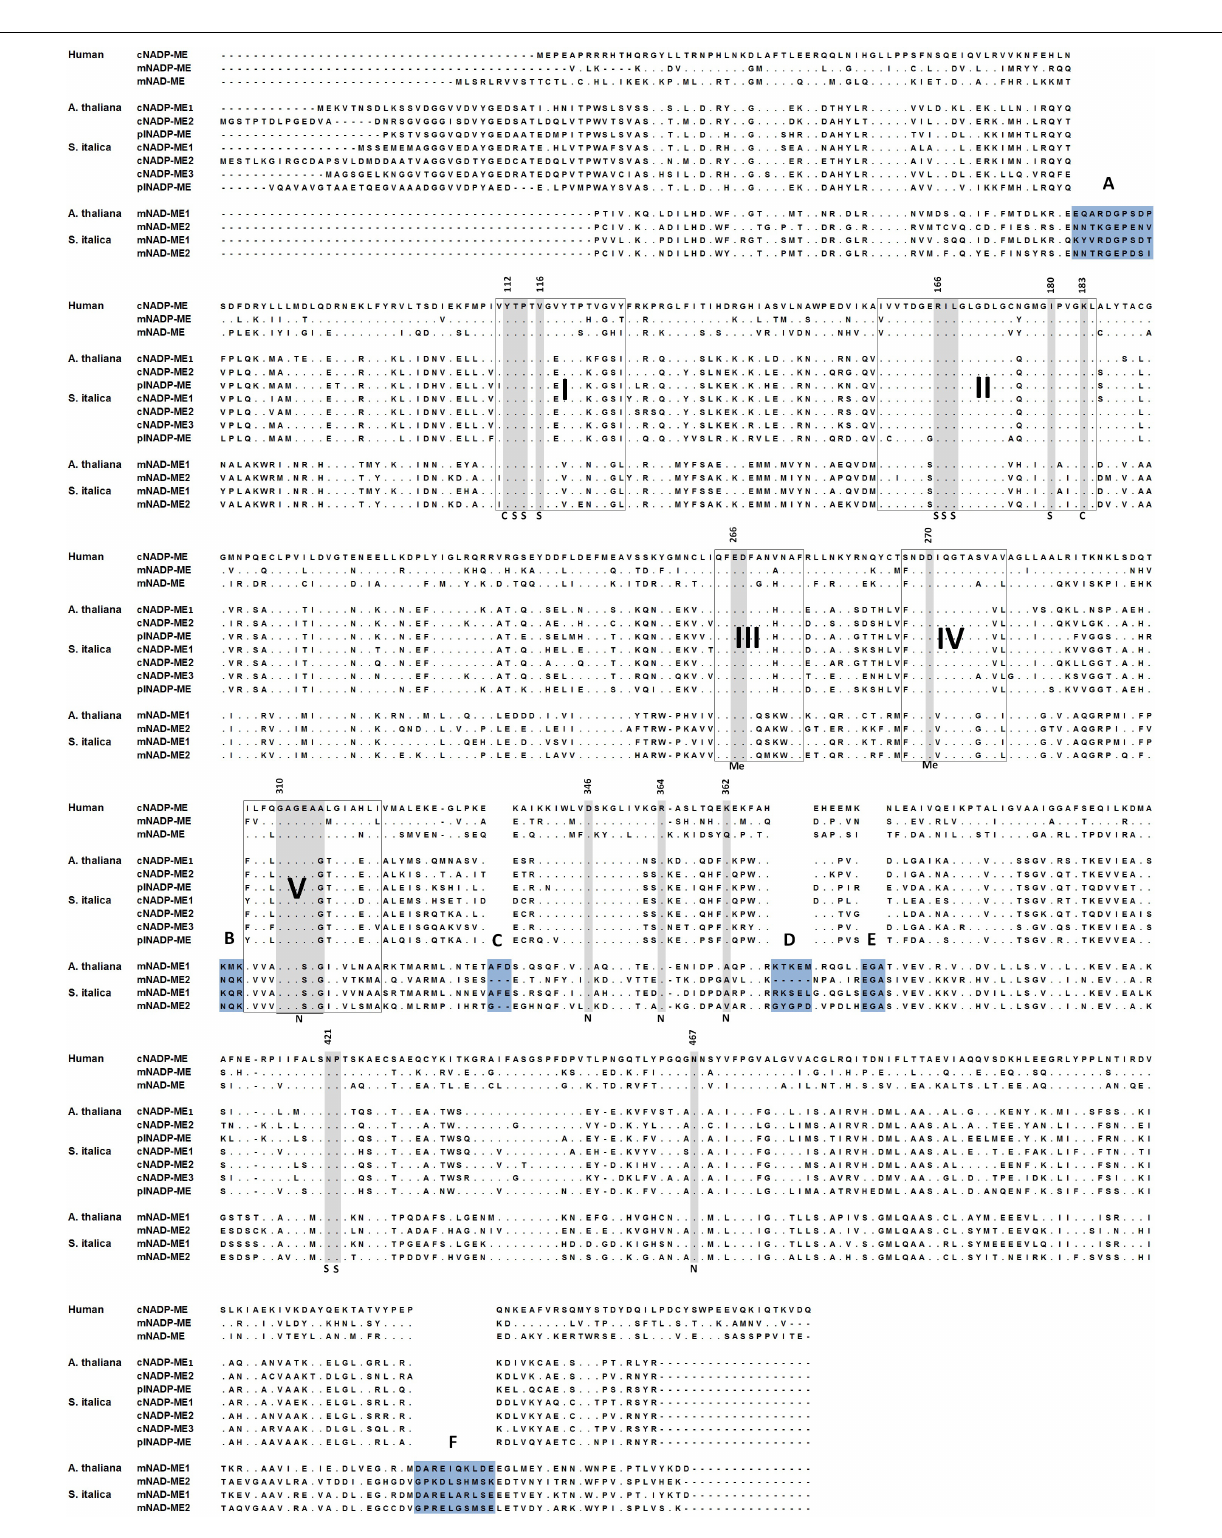
Frontiers in Plant Science |